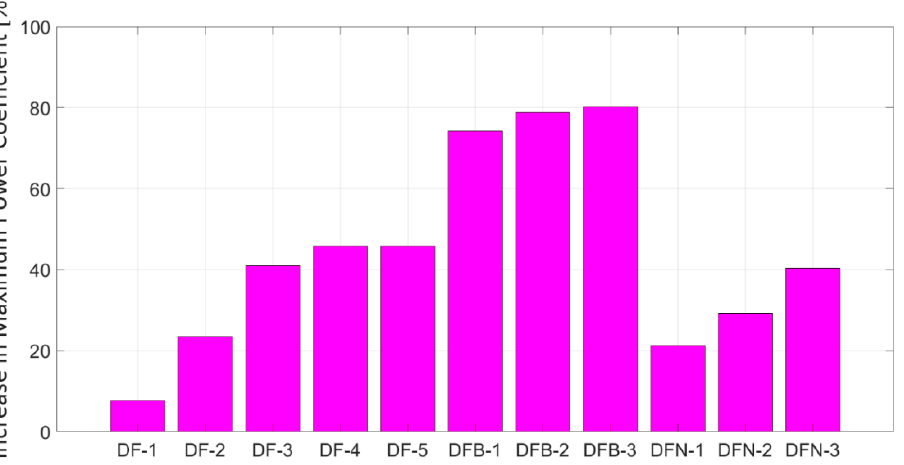
Figure 17. Increase in maximum power coefficient compared to the bare turbine.